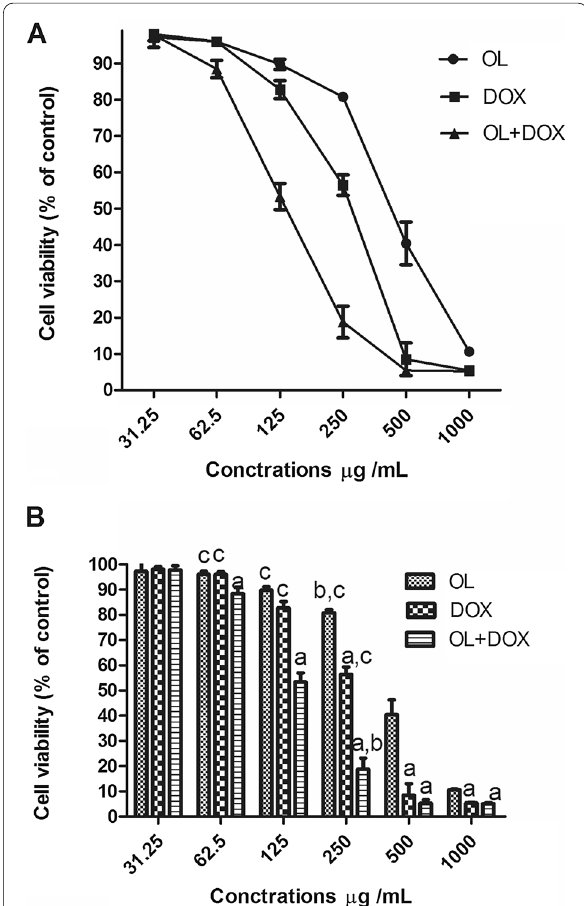
Fig. 4 Dose-dependent effect of OL, DOX, and OL DOX on viability + of HepG2 cells. HepG2 cells were cultured in 96-well plates at density of 1X 104 cells per well to sub confluent monolayers (80%) and treated with OL, DOX, and OL DOX ((31.25, 62.5, 125, 250, 500, + 1000 µg/ml) for 24 h. Cell viability was measured after 24 h using MTT assay. Results are presented as percentage of controls. The data are expressed as percentages of control cells. Each point represents the mean SD. of three independent experiments. a P < 0.05 versus OL; b ± P < 0.05 versus DOX; c P < 0.05 versus OL +